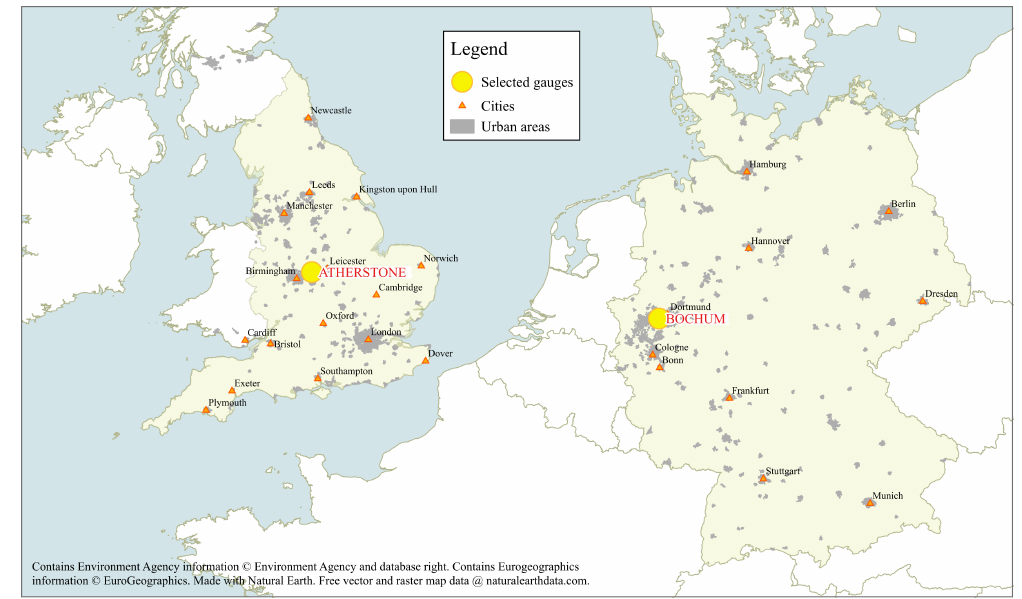
Figure 3. Plan showing the location of the UK and German rain gauges used in this